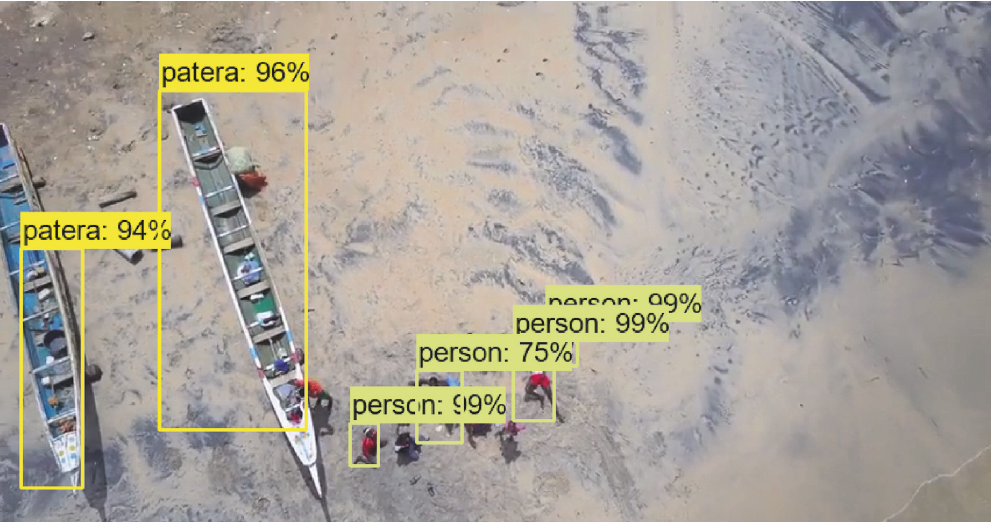
Figure 9: Image detection test from validation dataset.